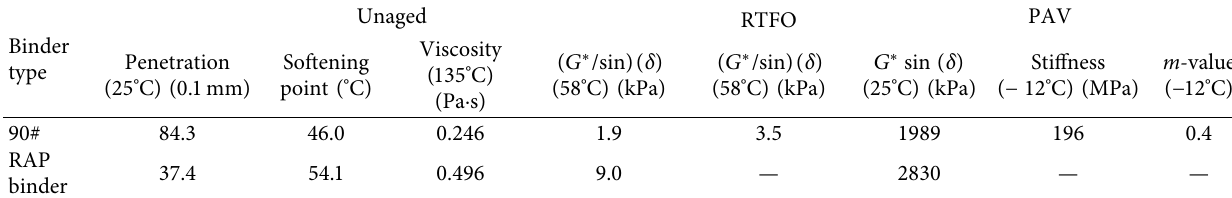
Table 1: Properties of 90# asphalt and RAP